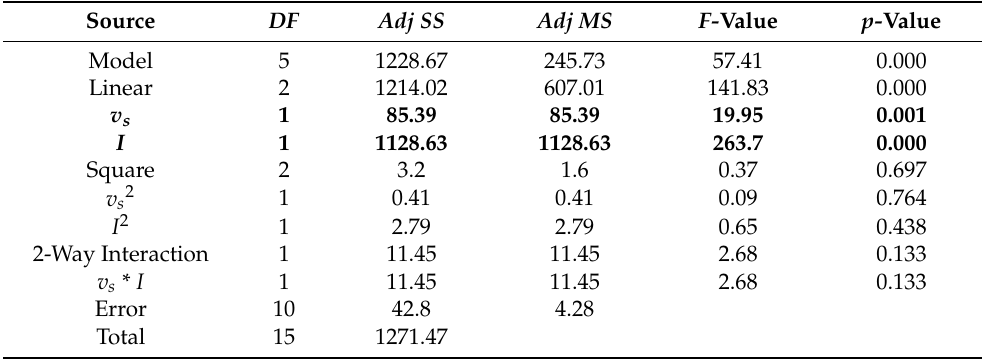
Table 6. ANOVA for the surface roughness ( Rz ). Significant regression coefficients are listed in bold